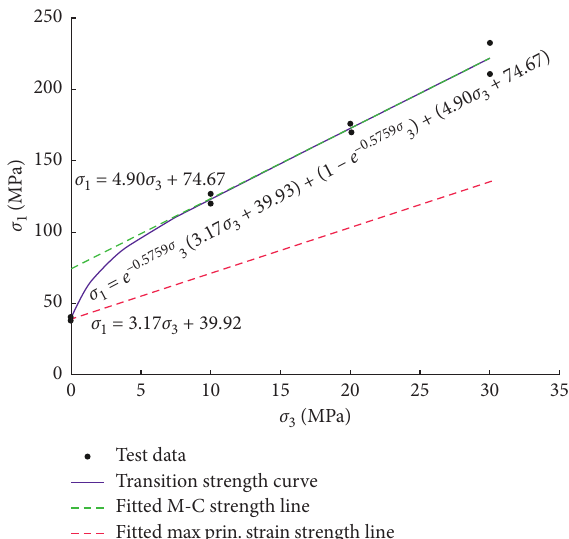
Figure 13: Comparison of three strength theories. Table 2: Parameters fitted and calculated from data of specimen with 30 mm diameter.